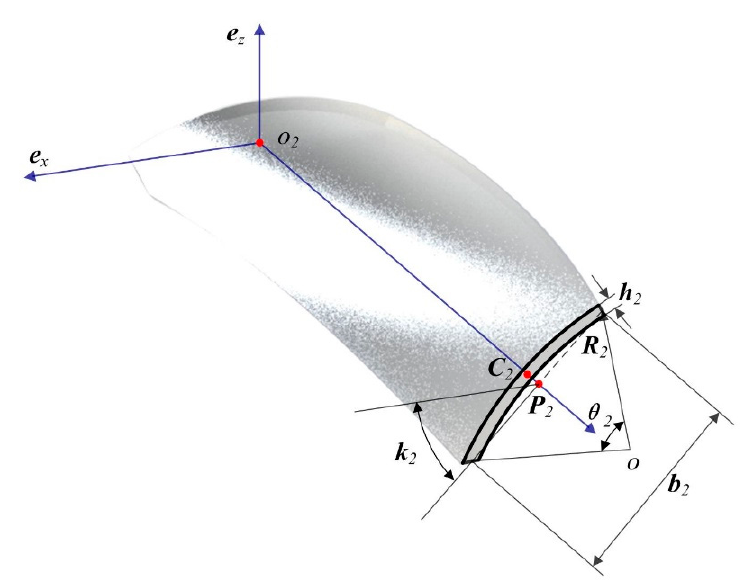
Figure 3. Geometries of a pre-twisted structure with arc profile cross section.